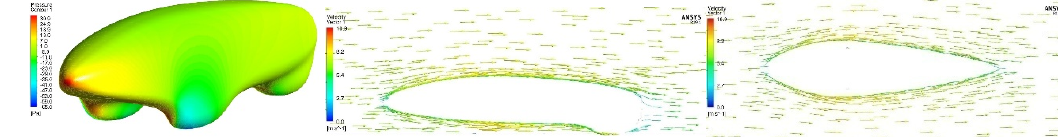
Figure 9. Air resistance simulation for body no. 2.